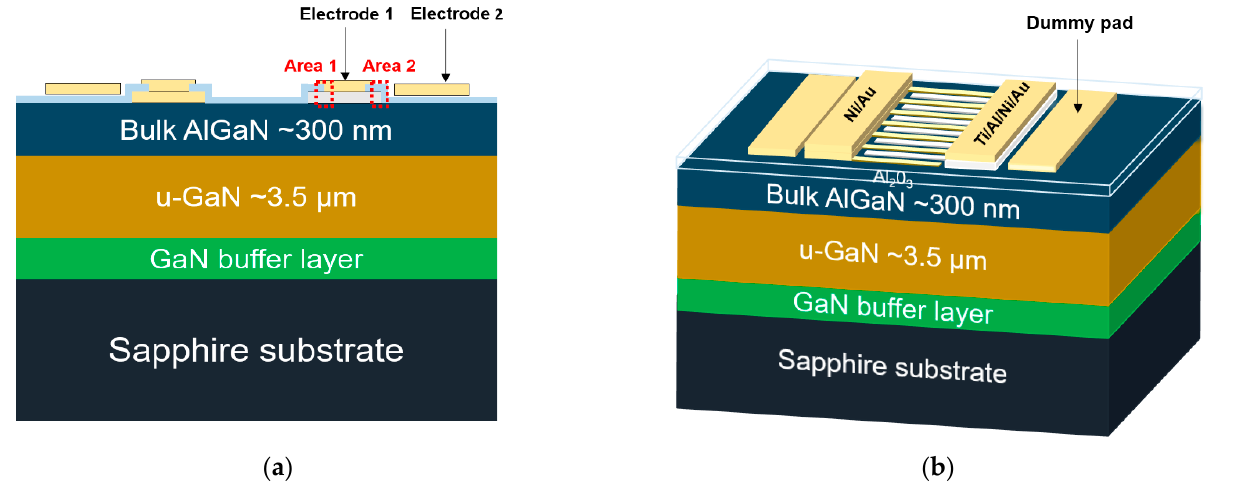
Figure 1. Schematics of the asymmetric MSM AlGaN UV sensor with 24% Al: ( a ) a cross-sectional view and ( b ) a three- dimensional view.